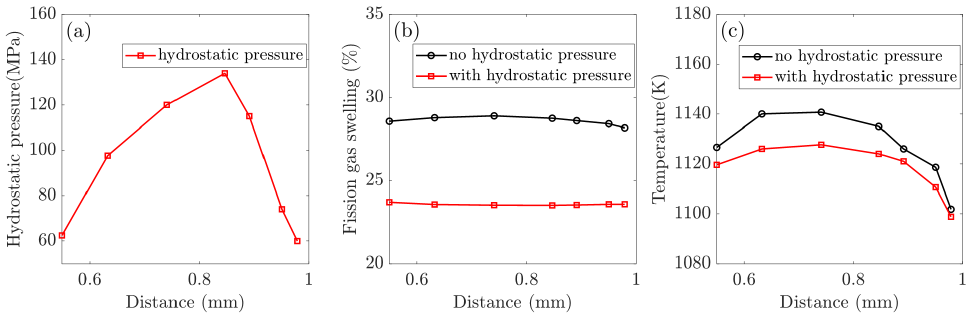
Figure 5. Influences of the hydrostatic pressure: ( a ) calculated hydrostatic pressure distribution along the particle path; ( b ) temperature evolution; and ( c ) fission gas swelling